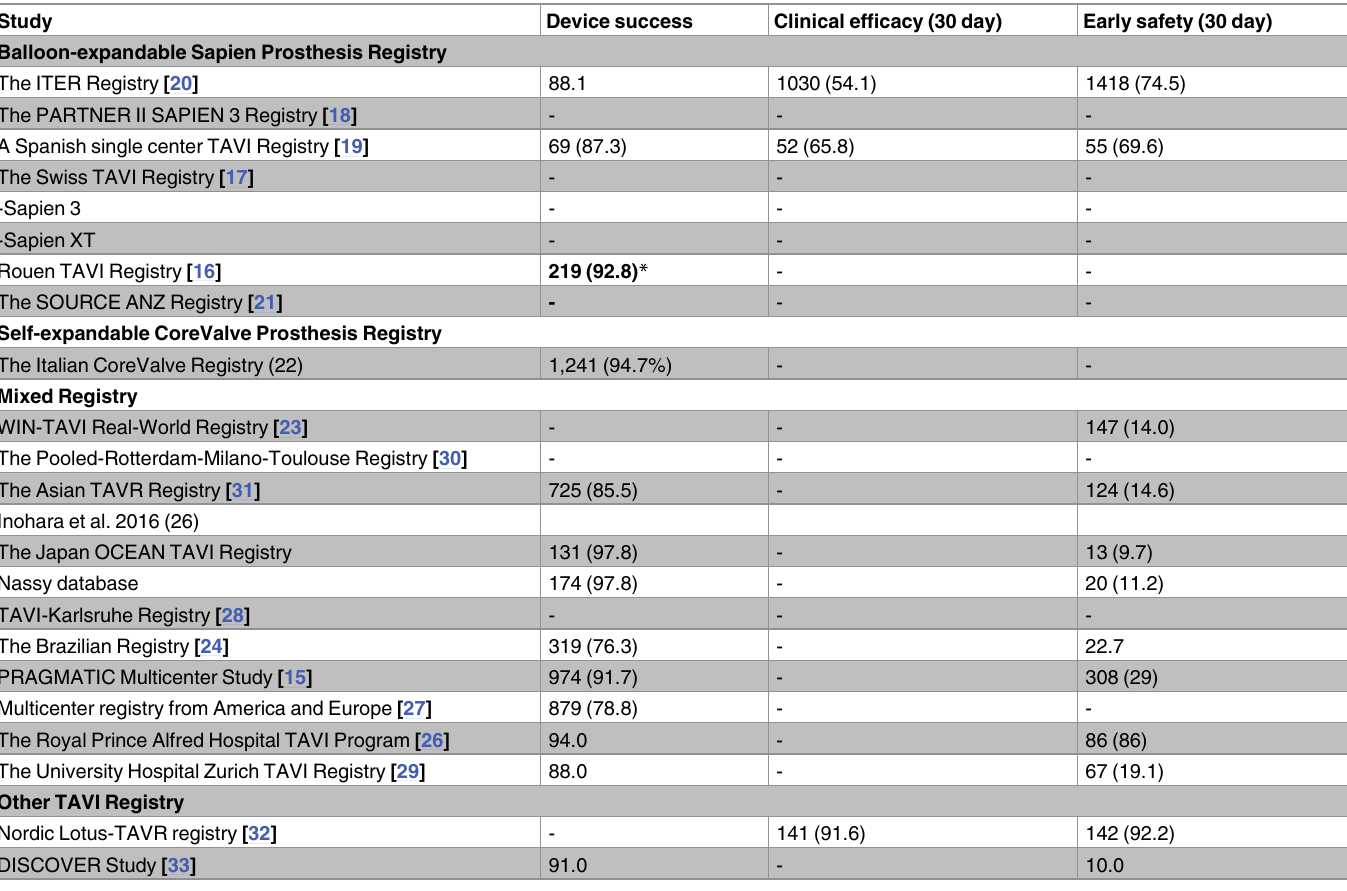
Table 4. Composite endpoints from individual studies based on the